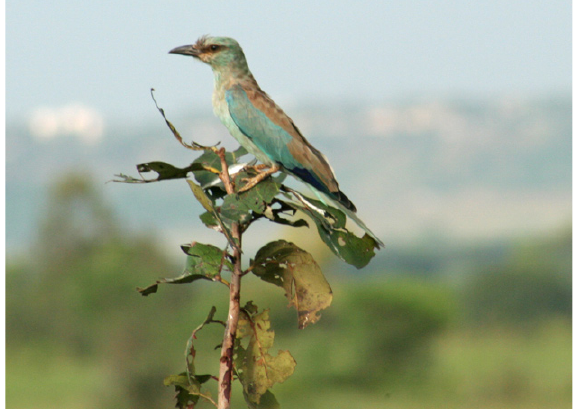
Image 1. European Roller Coracias garrulous